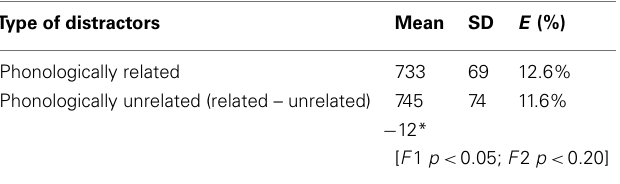
Table 3 | Experiment 3. Mean RTs (ms), SD, and percentage of errors ( E %), for phonologically related and unrelated